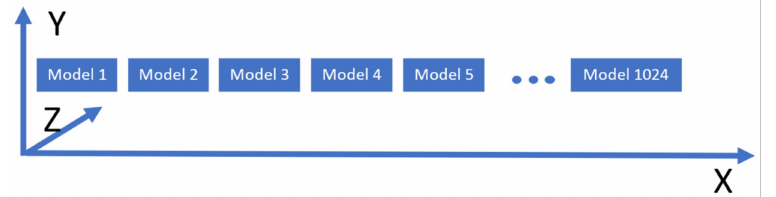
Figure 5. Overview of the work group layout of the compute shader used to calculate the switching criterion, with local_size_x = 1024, local_size_y = local_size_z = 1. Each box represents an instance of the data structure associated with a nominal model used to pass information to and from the